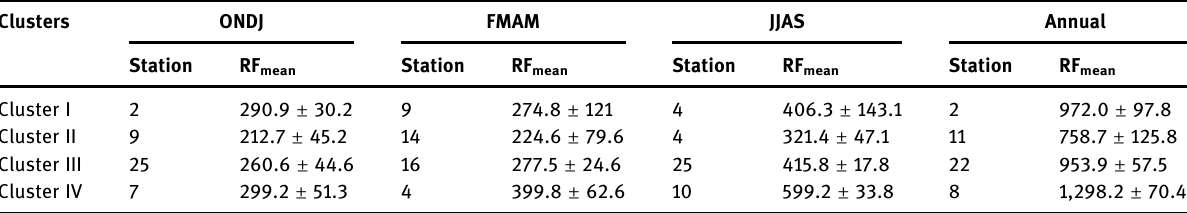
Table 5: Descriptive statistics of cluster - wise mean rainfall for di ff erent seasons